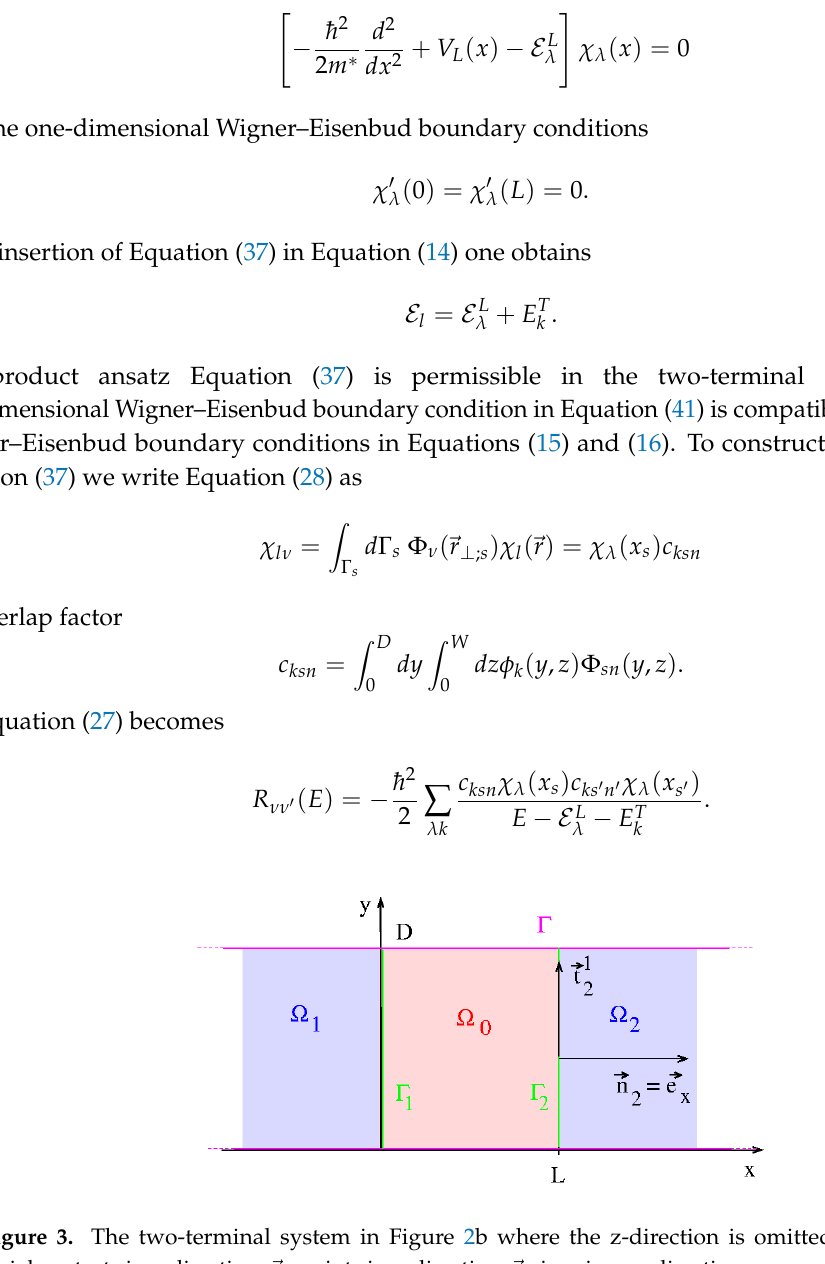
Figure 3. The two-terminal system in Figure 2b where the z-direction is omitted for simplicity. Axial contacts in x-direction: (cid:126) n 2 points in x -direction, (cid:126) n 1 in minus x